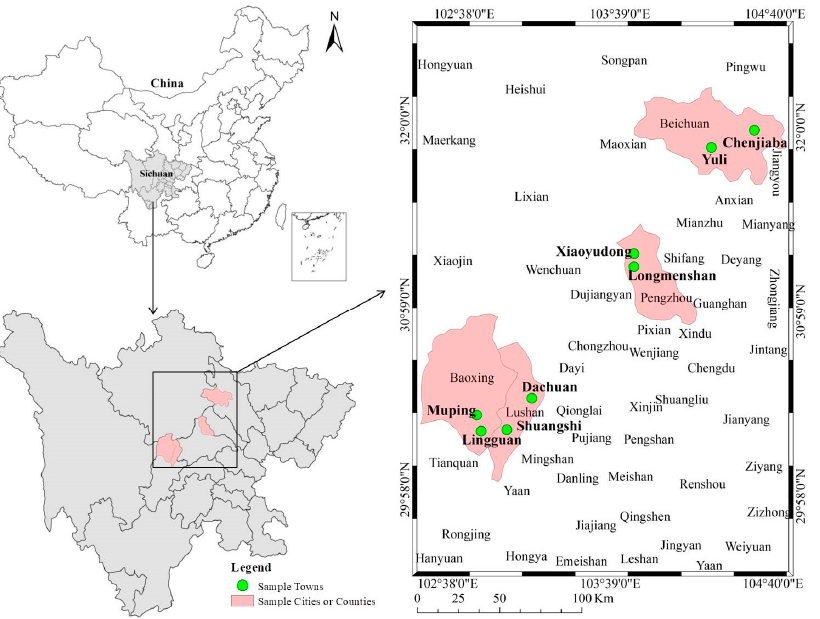
Figure 3. Location map of sample counties and towns (Figure source please see [53]). Table 1. Definition and descriptive statistics of the variables in the